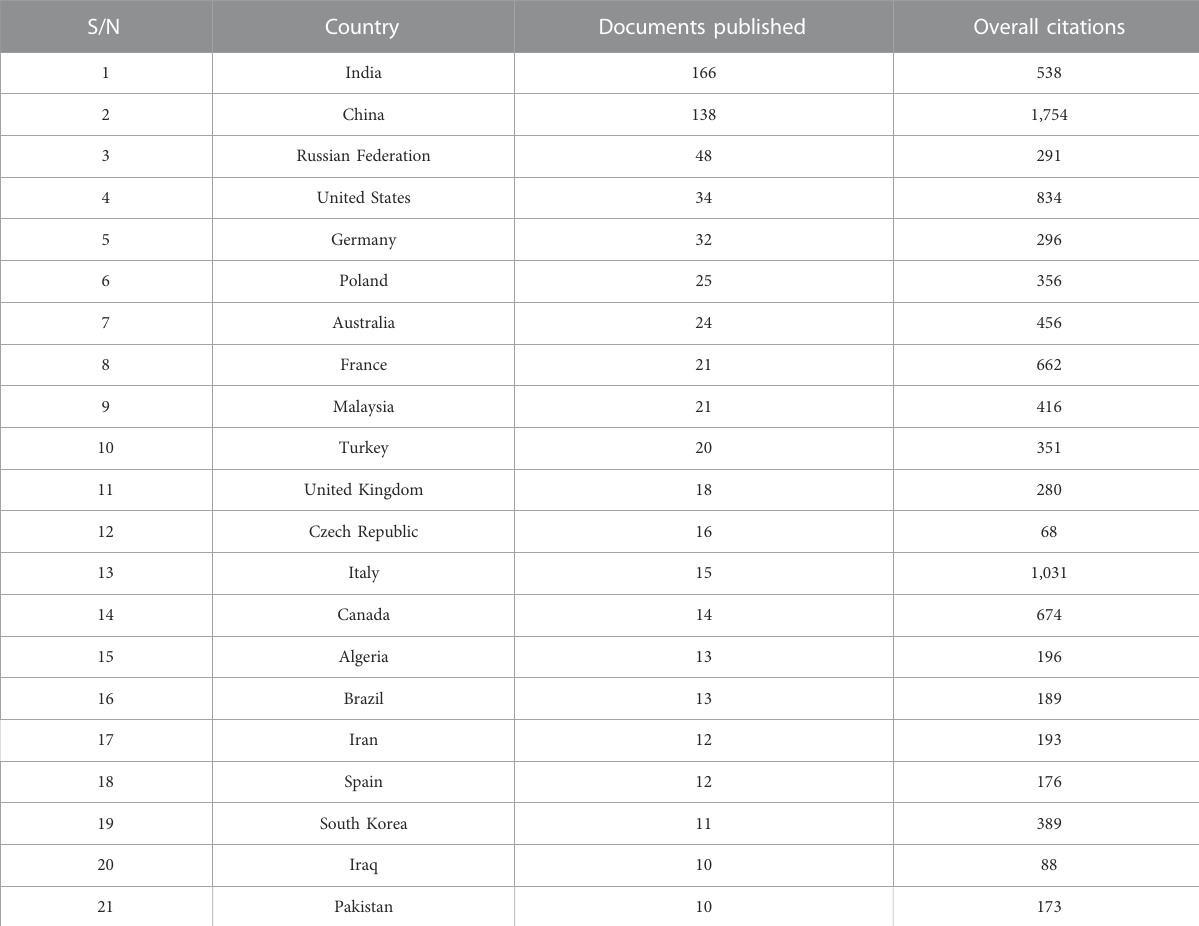
TABLE 3 Countries with at least 10 papers in the mineral fi ber-reinforced concrete